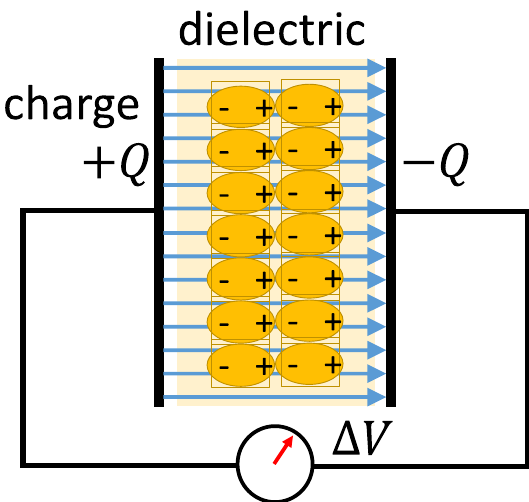
Figure 18. A measure of the relative dielectric constant K can be obtained by interposing the dielectric material (insulator) between the plates of a charged capacitor and measuring the potential dif- ference in the absence and in the presence of the dielectric: K =ΔV0/ΔV > 1 [16].